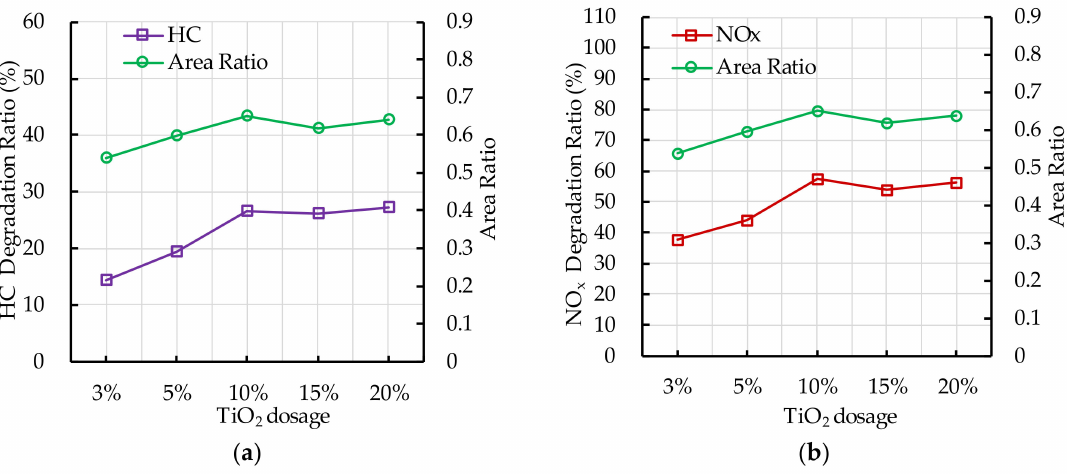
Figure 19. E ff ect of TiO 2 dosage on photocatalytic degradation and area ratio: ( a ) HC; ( b ) NO x